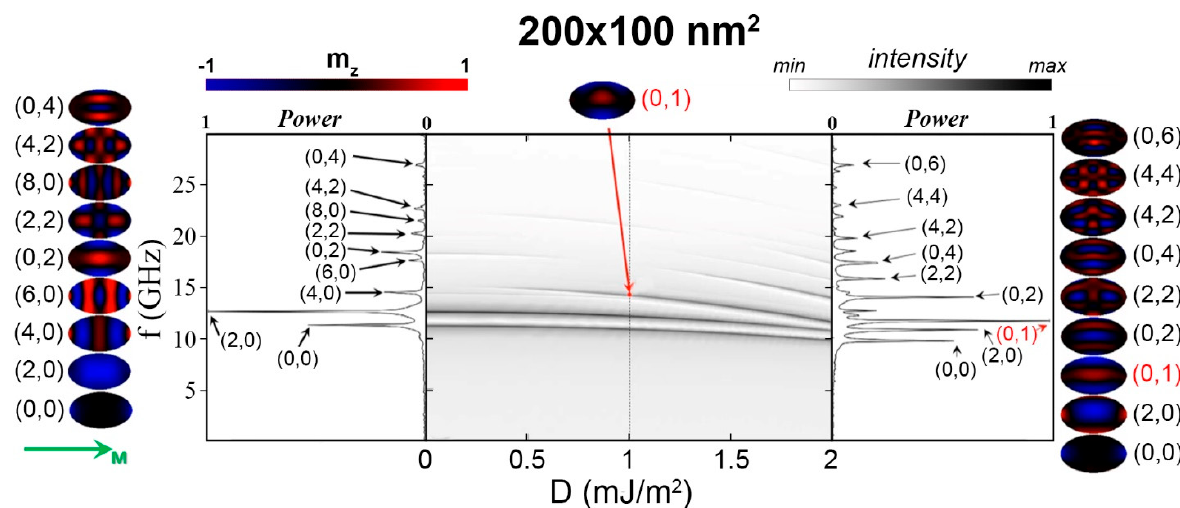
Figure 4. Central panel: dependence of the frequencies of the spin wave eigenmodes on the DMI constant D for the elliptical dot of lateral dimensions 200 × 100 nm 2 . On the left- and right-hand sides, the intensity spectra corresponding to D = 0 and 2 mJ/m 2 are reported, respectively, together with the color insets that represent the spatial profile of the dynamical magnetization, expressed as the product of the modulus of the dynamical magnetization by the sign of its phase. The animations with the movies of the dynamics of all the modes for several values of D are available in the supplemental material.